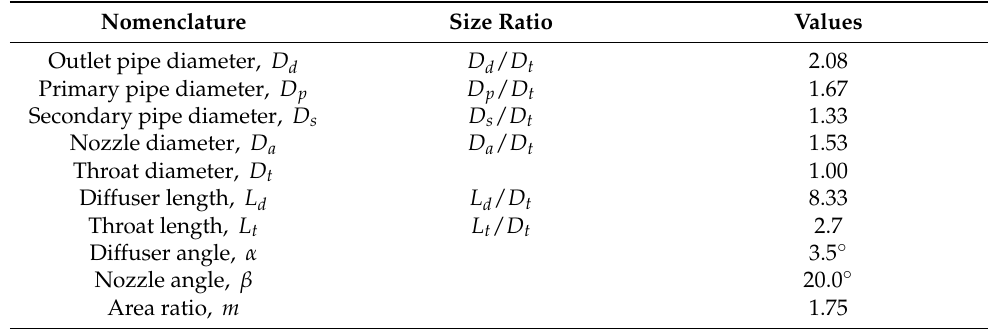
Figure 2. Three-dimensional and schematic views of annular jet pump (AJP) model. Table 1. Specification of annular jet pump model [29].